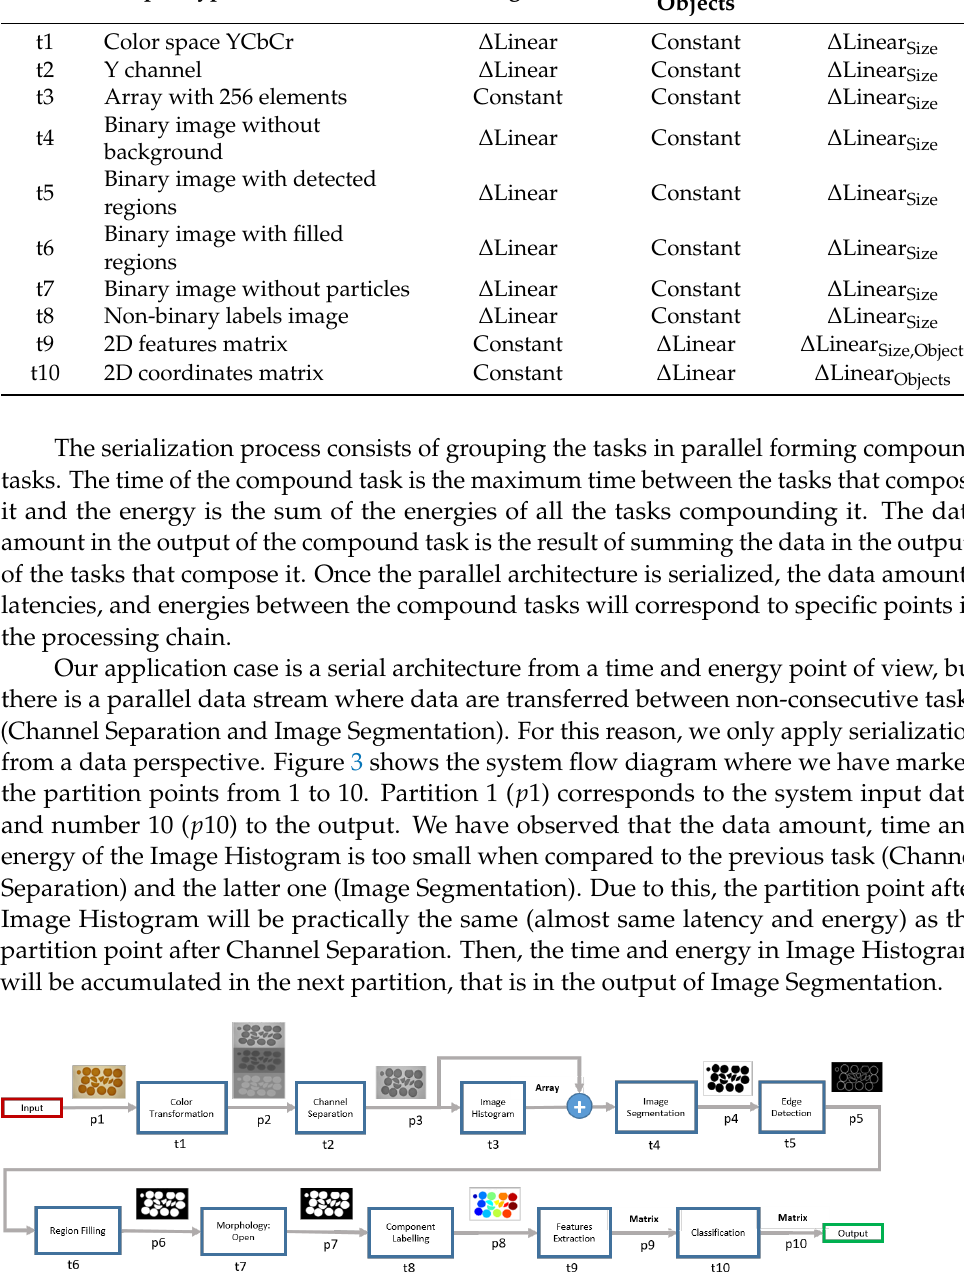
Figure 3. System flow diagram with numbers indicating the partition points to